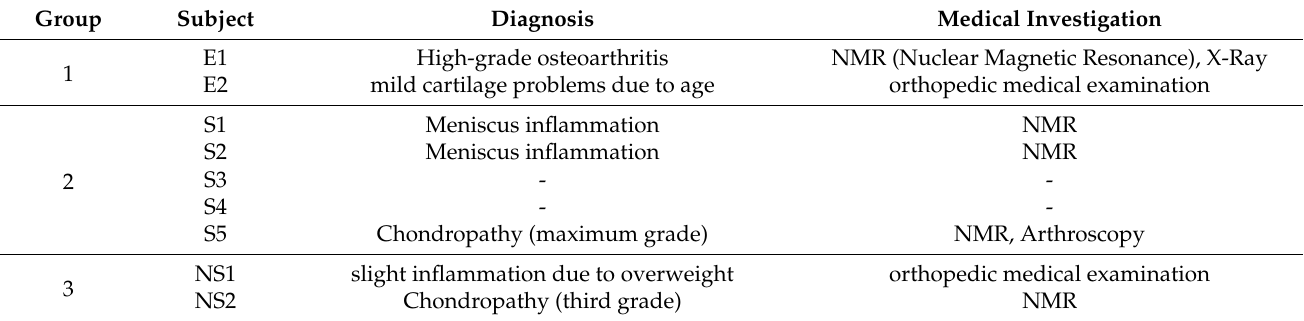
Table 1. Medical diagnosis and related investigation techniques for all the examined subjects. Subjects S3 and S4 do not suffer from any knee-related medical condition.